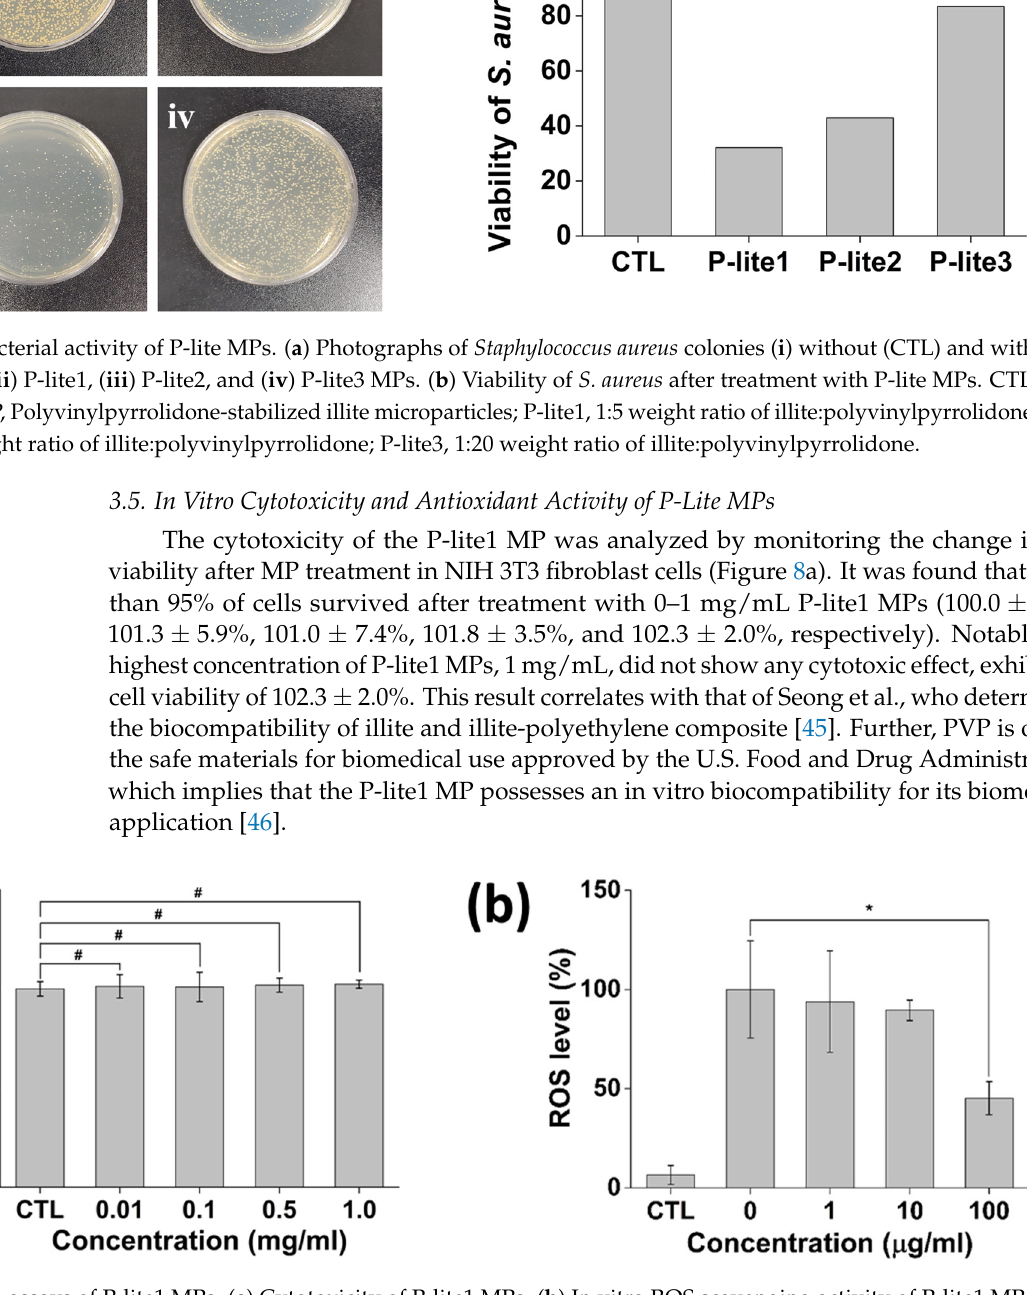
Figure 8. In vitro assays of P-lite1 MPs. ( a ) Cytotoxicity of P-lite1 MPs. ( b ) In vitro ROS scavenging activity of P-lite1 MPs. CTL, control; ROS, reactive oxygen species; # p > 0.05; * p <